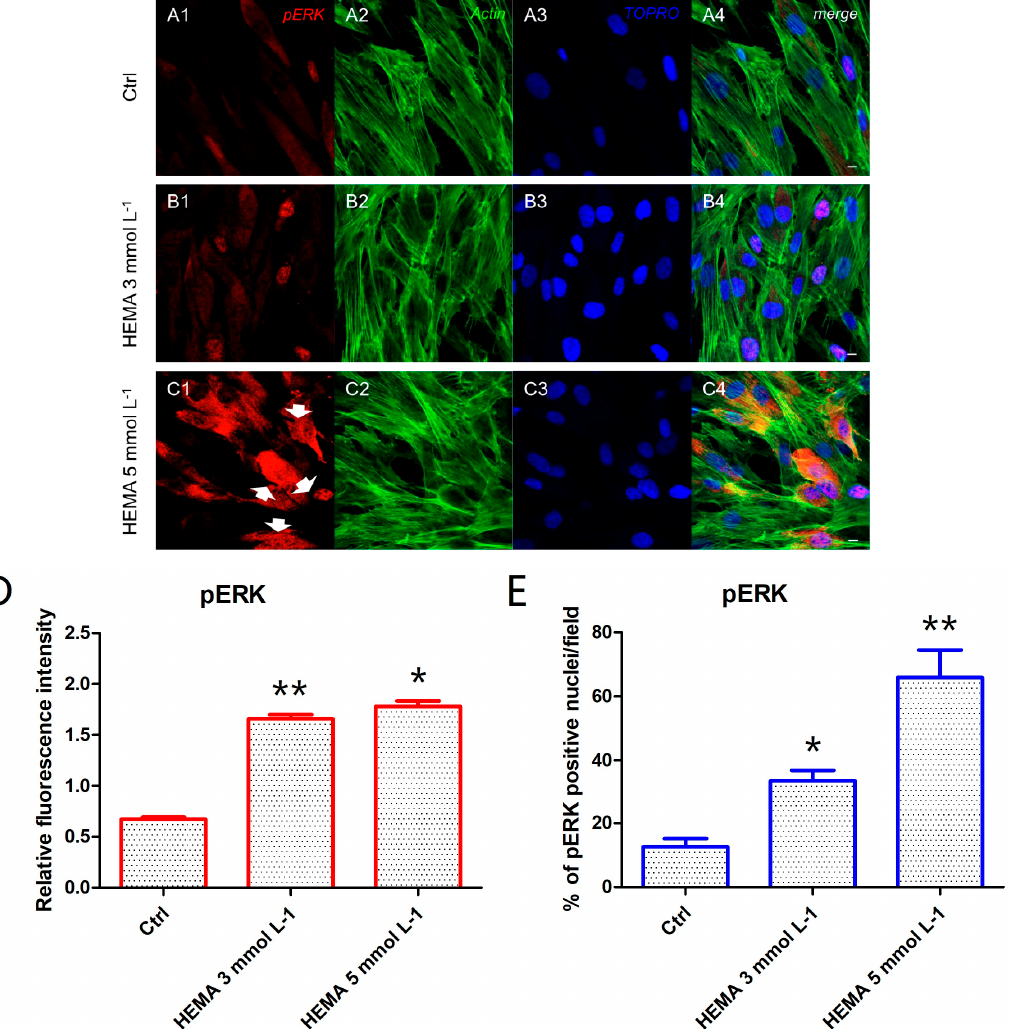
Figure 6. pERK expression. ( A1 ) Untreated cells showed a low positive expression for pERK. ( A2 ) Actin cytoskeleton in untreated hDPSCs. ( A3 ) Nuclei in untreated hDPSCs. ( A4 ) Merged picture of abovementioned channels in untreated hDPSCs. ( B1 ) Cells treated with HEMA 3 mmol L − 1 showed a positive expression for pERK. ( B2 ) Actin cytoskeleton in HEMA 3 mmol L − 1 treated hDPSCs. ( B3 ) Nuclei in HEMA 3 mmol L − 1 treated hDPSCs. ( B4 ) Merged picture of abovementioned channels in HEMA 3 mmol L − 1 treated hDPSCs. ( C1 ) Cells treated with HEMA 5 mmol L − 1 showed a strong positive expression for pERK, with a nuclear localization (arrows). ( C2 ) Actin cytoskeleton in HEMA 5 mmol L − 1 treated hDPSCs. ( C3 ) Nuclei in HEMA 5 mmol L − 1 treated hDPSCs. ( C4 ) Merged picture of abovementioned channels in HEMA 5 mmol L − 1 treated hDPSCs. ( D ) The relative fluorescent intensity of pERK was analyzed using NIS-Elements AR imaging software. Data are presented as the mean of 30 measurements ± standard deviation. ( E ) Analysis of the percentage of pERK-positive nuclei/field. * p < 0.05; ** p < 0.01. Green fluorescence: actin cytoskeleton, red fluorescence: pERK, blue fluorescence: nuclei. Magnification: 63×. Scale bar: 10 μ m.